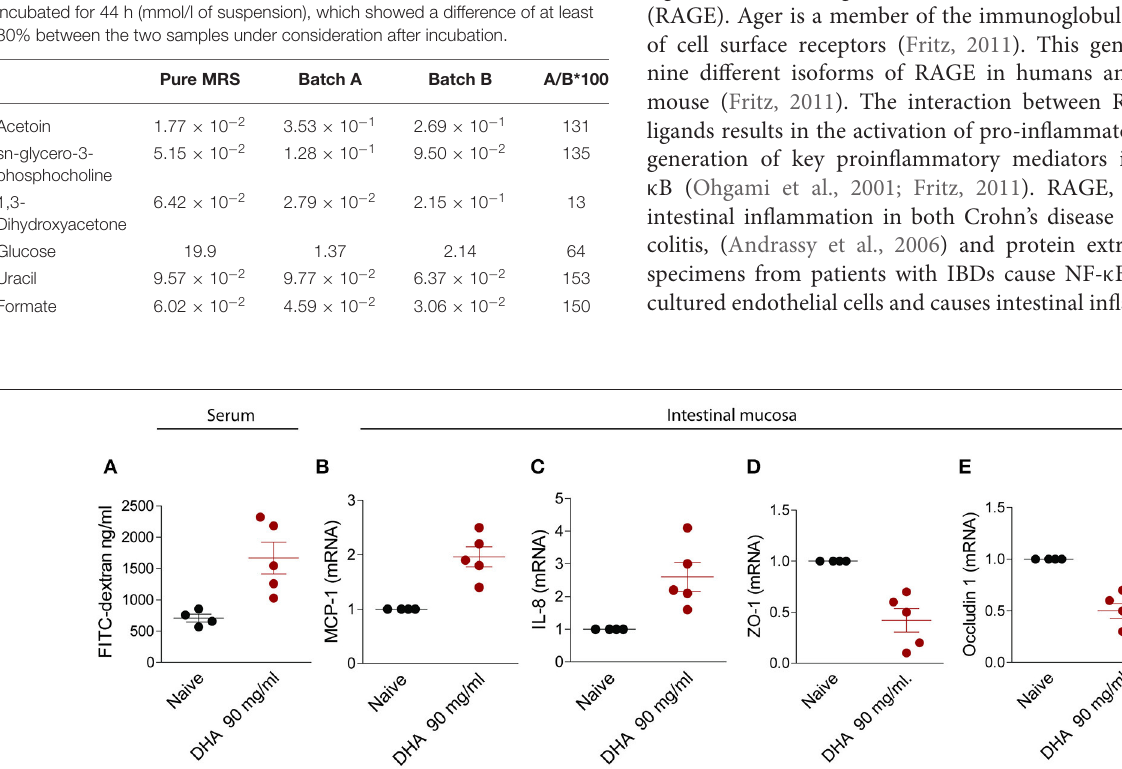
FIGURE 5 | Effect of feeding mice with a high dose DHA, 90 mg/ml/day. Intestinal permeability was measured after 2 weeks of diet with FITC-dextran (A) . Quantitative rtPCR analysis of MCP-1 (B) , IL-8 (C) , zonulin1 (D) , and occludin1 (E) . Data are the mean ± SEM of five mice per group (* P < 0.05).